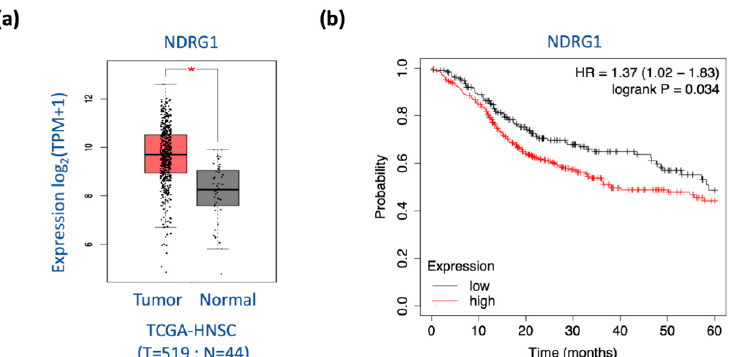
Figure 8. High level of NDRG1 is significantly associated with poor survival in HNC patients. ( a ) In HNC patients, NDRG1 is overexpressed in the tumors compared to the normal tissues from TCGA-HNSC datasets generated by GEPIA2 website. The relative expression levels were shown. ( b ) Higher level of NDRG1 expression is associated with poor prognosis in HNC patients, as determined by Kaplan–Meier survival analysis via KM-Plotter online tool from the HNC dataset (N = 500). * p < 0.05; t